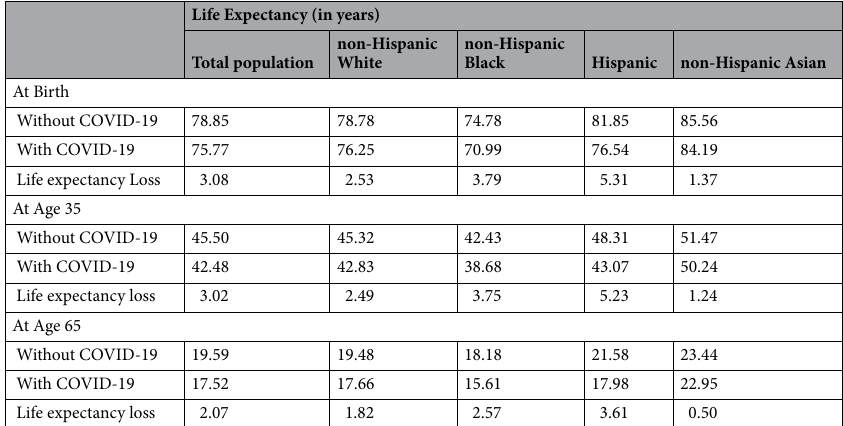
Table 1. Life expectancy losses in the United States from January 1, 2020, to May 7, 2022, by race and ethnicity. Estimated as the contribution of COVID-19 deaths towards all-cause mortality in the US life tables by Hispanic origin, race, and sex, based on age-specific death rates in